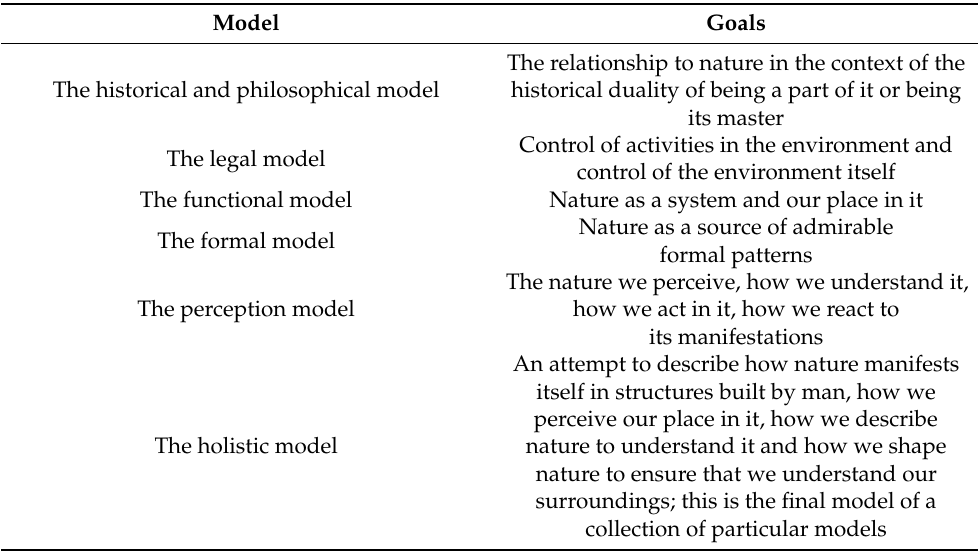
Table 3. A brief description of the theoretical models included in the Modelling Nature approach adapted from